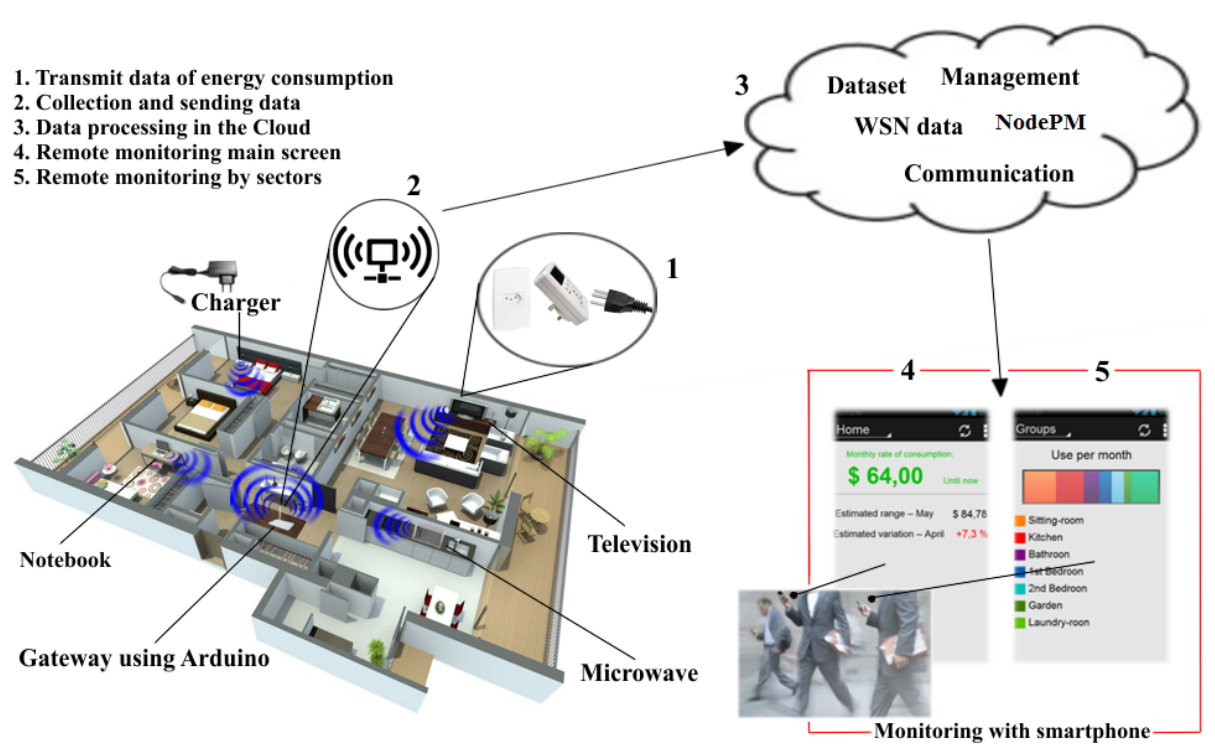
Figure 1. Operational scenario of the platform. WSN, wireless sensors network; NodePM, Novelty Detection Power Meter